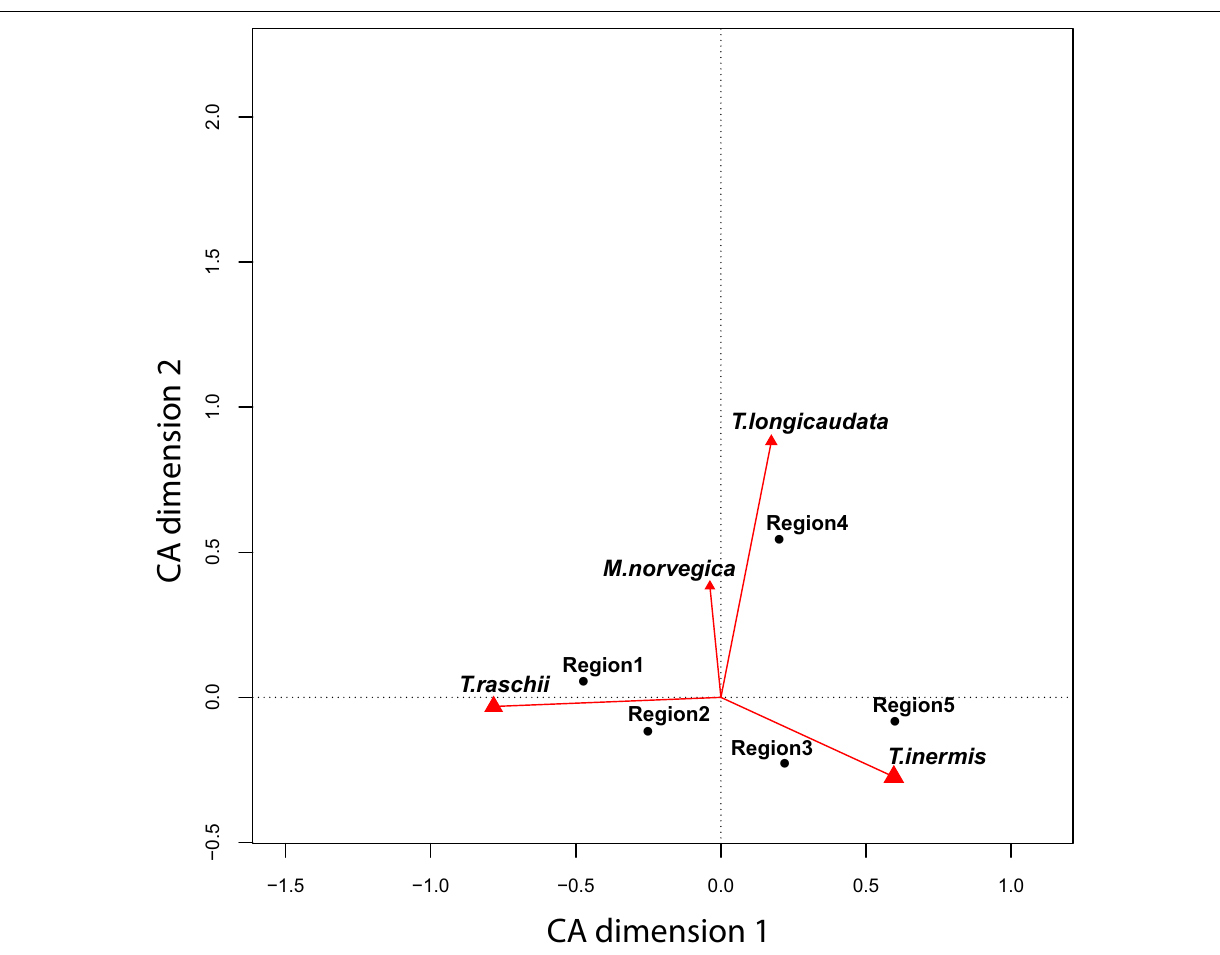
represented by a continuum between T. raschii (left) and T. inermis (right), whereas the vertical axis is largely described by the contribution of the M. norvegica and T. longicaudata . Whereas Region 5 is strongly characterized by T. inermis , T. raschii is more dominant in Regions 1 and 2. Region 4 has a high component of the taxa contributing to the vertical